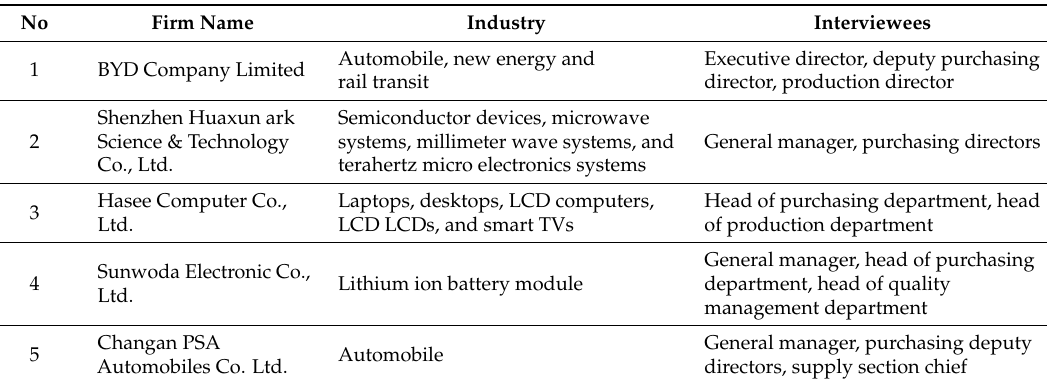
Table 1. Basic information of enterprises interviewed.